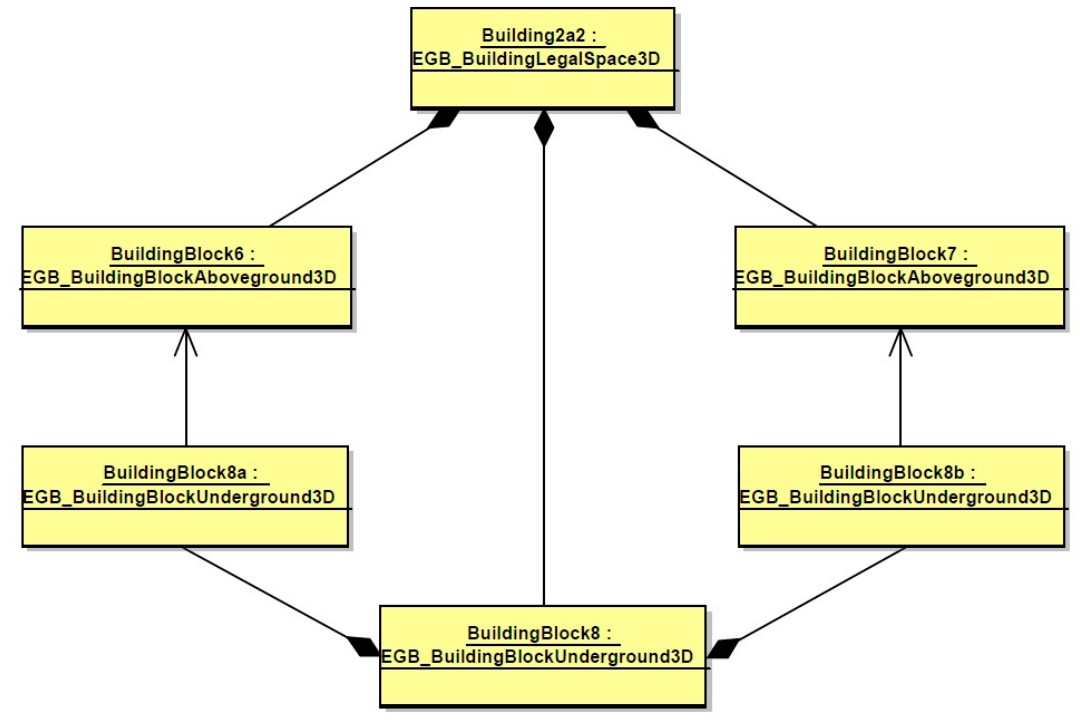
Figure 15. The UML schema of instance where the underground part is divided, all within one property.